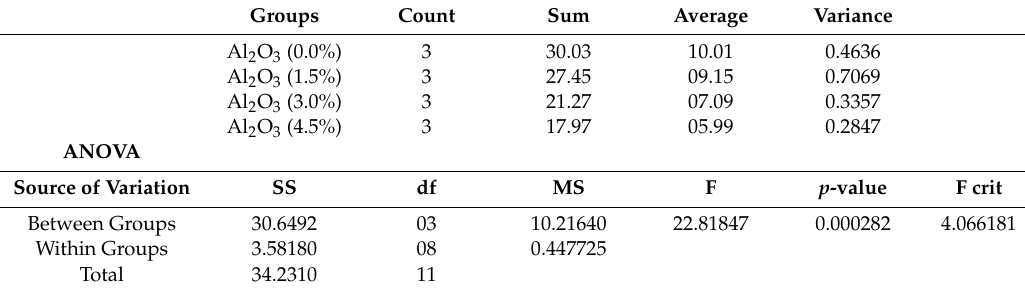
Table 7. Thickness swelling values of Al 2 O 3 -UF MDF for various treatments.